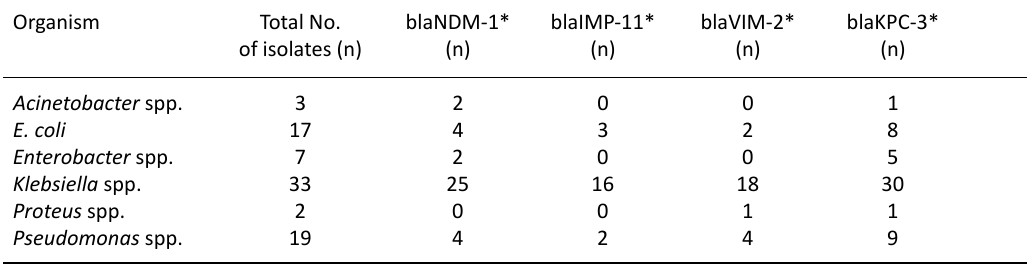
table 5. Molecular characterization and Carbapenem gene distribution in clinical isolates Organism Total No.